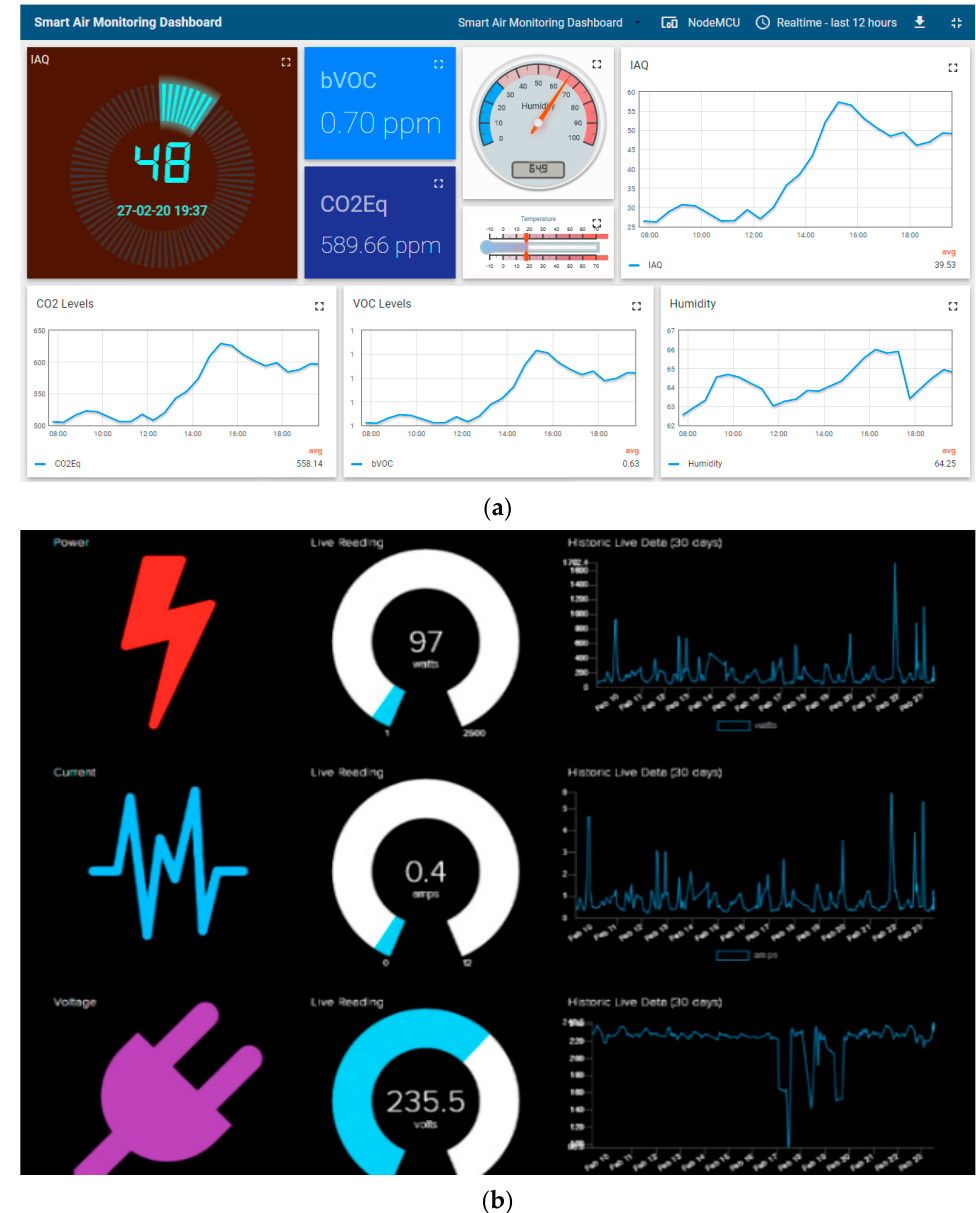
Figure 6. Dashboards of the implemented platform, monitoring air quality ( a ) and energy ( b ) tested for a public